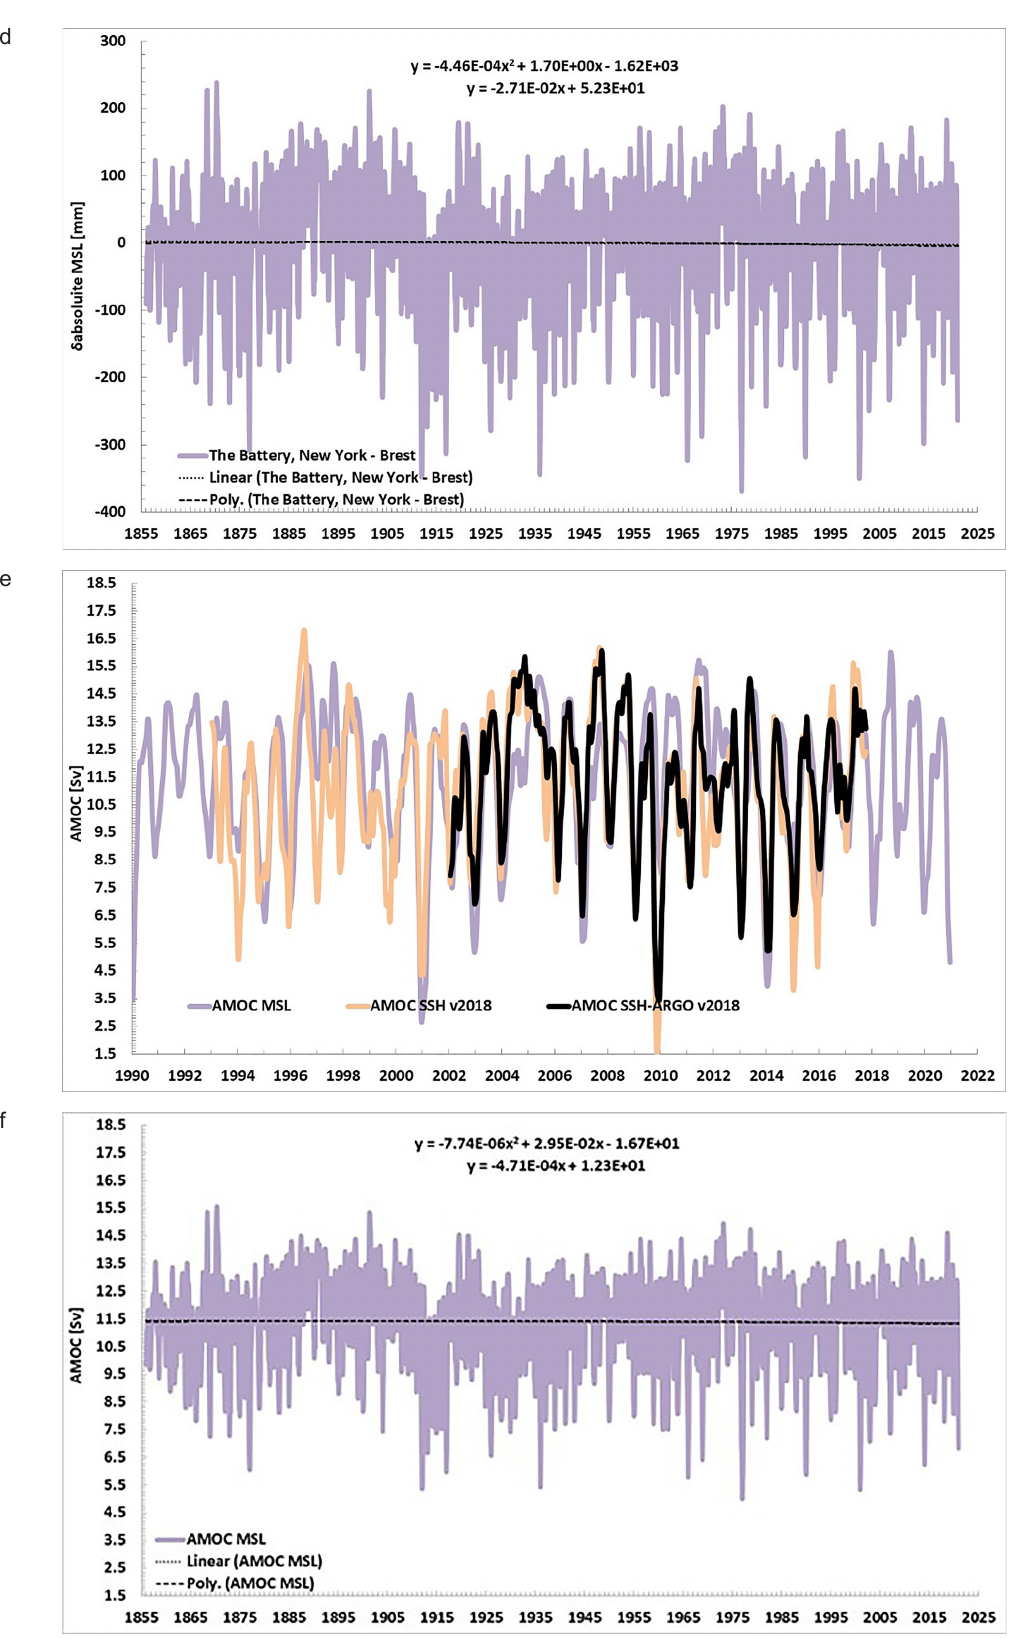
Fig. 1. (d) difference between New York and Brest. (e) AMOC MSL, AMOC SSH v2018 and AMOC SSH-ARGO v 2018 compared. (f) AMOC MSL since